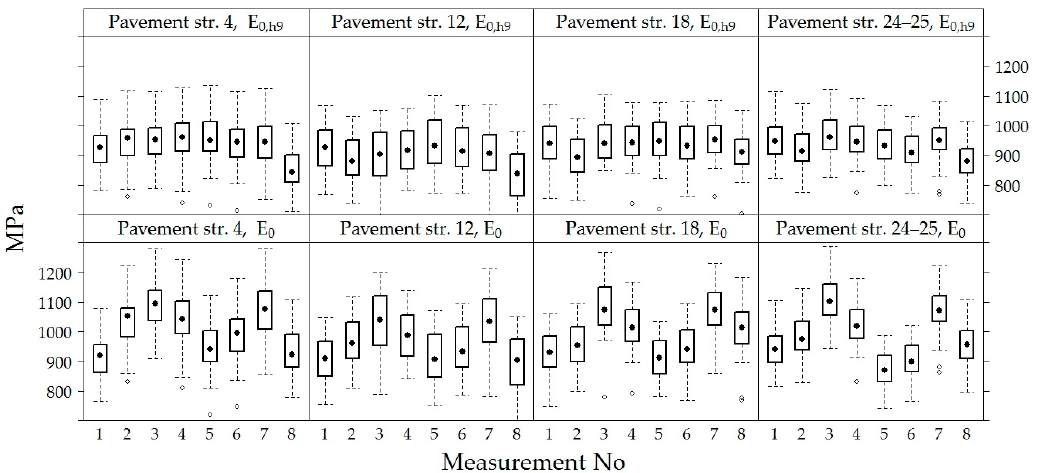
Figure 13. The distribution of individual E 0 and E 0,h9 values for each of the road PS.